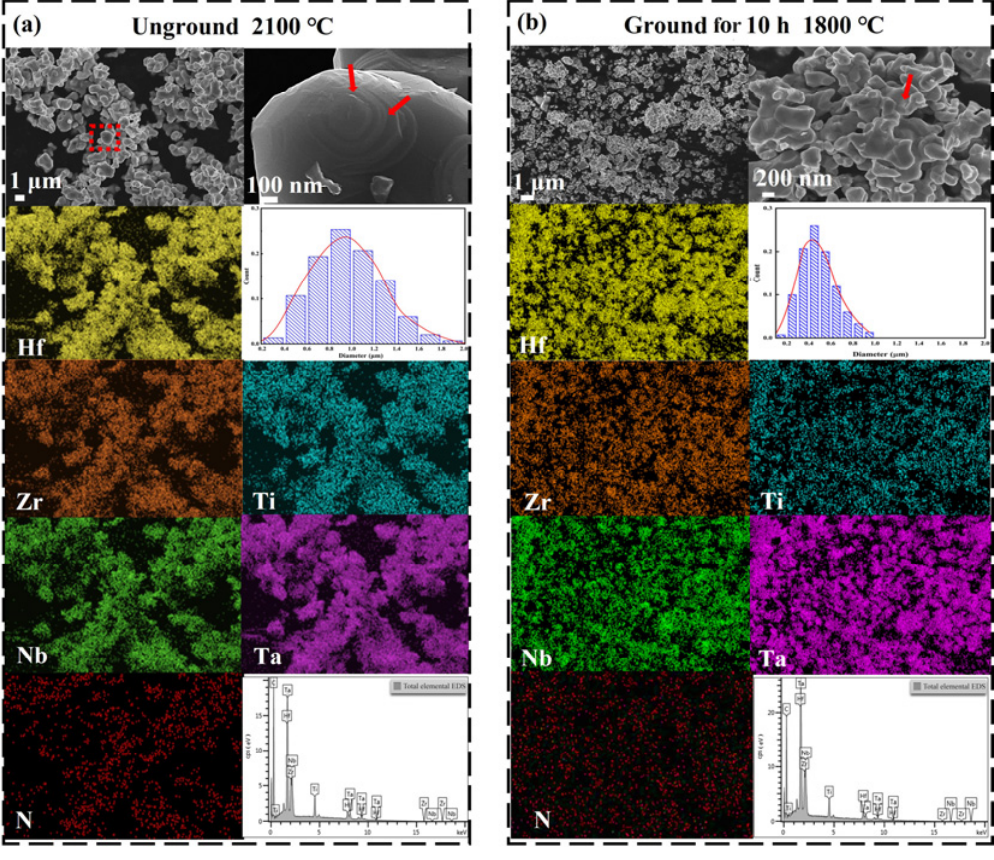
Fig. 3 SEM images, particle size distributions, and EDS mappings of high-entropy (HfZrTiNbTa)N powders synthesized from (a) raw material mixtures unground and sintered at 2100 and (b) raw material mixtures ground ℃ for 10 h and sintered at 1800 .